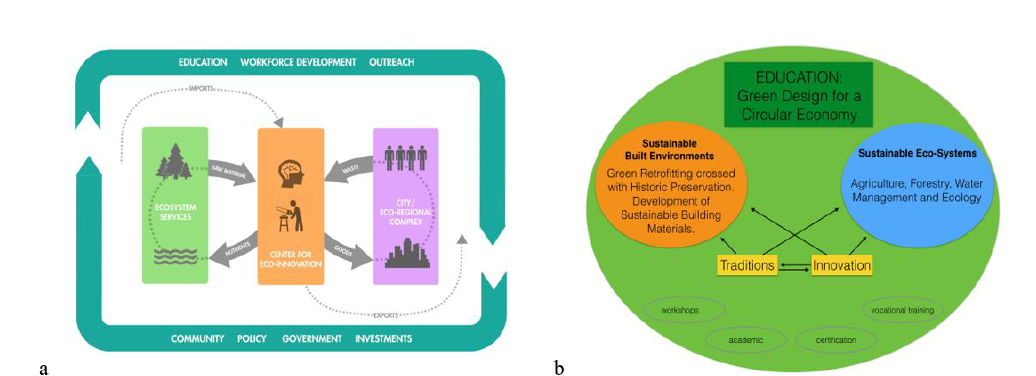
Figure 7. (a) Circularity Diagram -K˝oszeg Center for Eco-Innovation (b) Proposed Educational